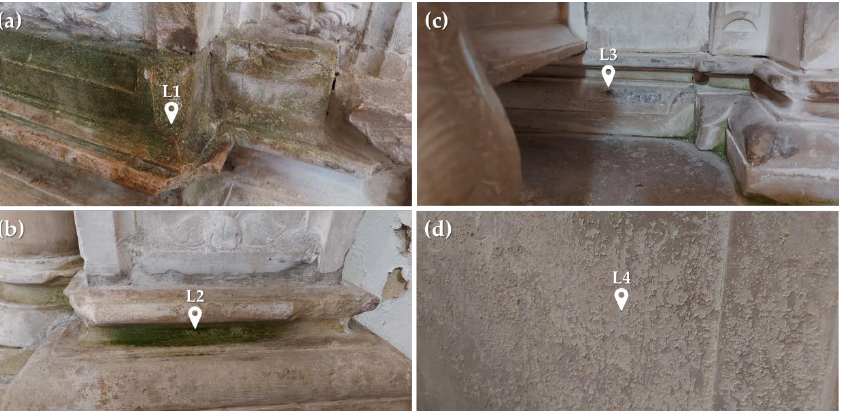
Figure 2. Details of the sampling points ( a ) L1, DGB at the base of the left pillar in D. Duarte de Lemos tomb; ( b ) L2, GB at the base of the right pillar in Gomes Martins de Lemos and his son, João Gomes de Lemos tomb; ( c ) L3, BD behind the tomb chest of D. Maria de Azevedo and D. Violante de Sequeira and ( d ) L4, SE beneath L3, closest to the floor.